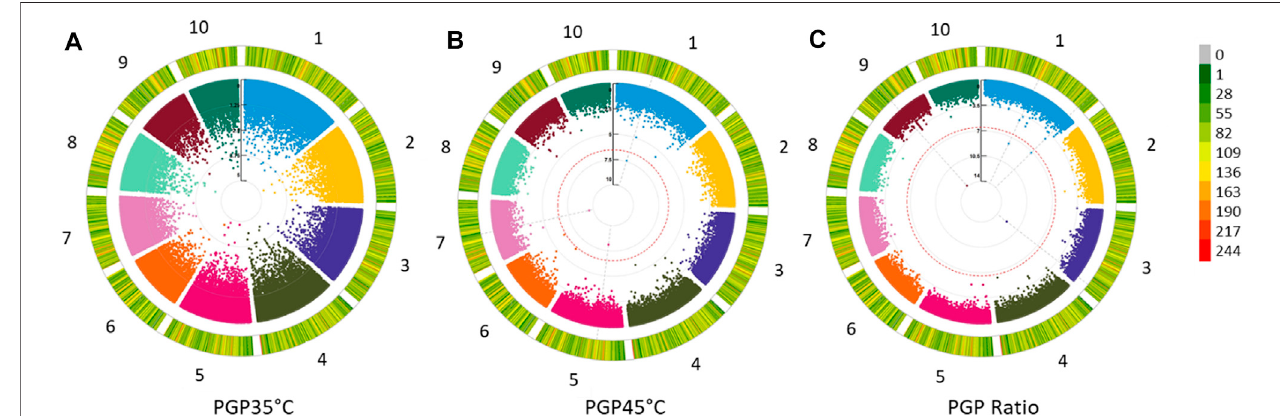
FIGURE 2 | Circular Manhattan plots revealing signi fi cant QTLs (A) PGP35 ° C: Pollen Germination percentage at 35 ° C; (B) PGP45 ° C: Pollen Germination percentageat45 ° Cand (C) PGPRatio:PollenGerminationpercentageratiobetween35and45 ° Cin122maizeinbredlines.The − log 10 p -valuesareusedtoplotagainst each of the 10 chromosomes represented in 10 different colors. The outer most circle indicates the marker density and side legend bar indicates the number of SNPs within a 1 MB window size.